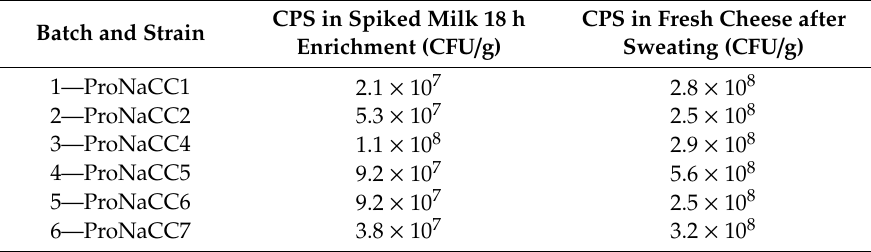
Table 9. Enterotoxins production in vivo: immunochemical qualitative and quantitative methods. Batch and